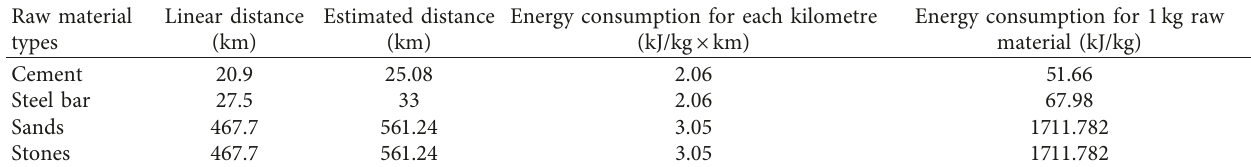
Table 9: Energy consumption of raw material transportation.